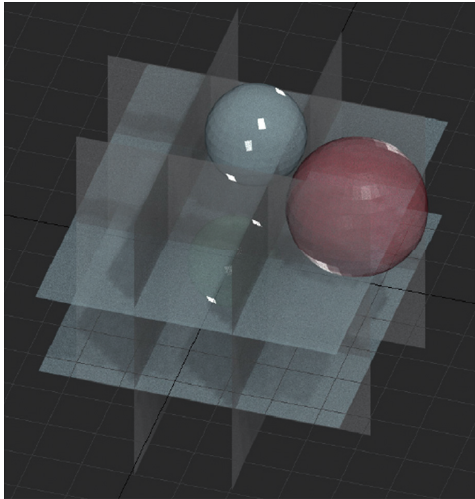
Figure 16: MBR model in Example 2(b).